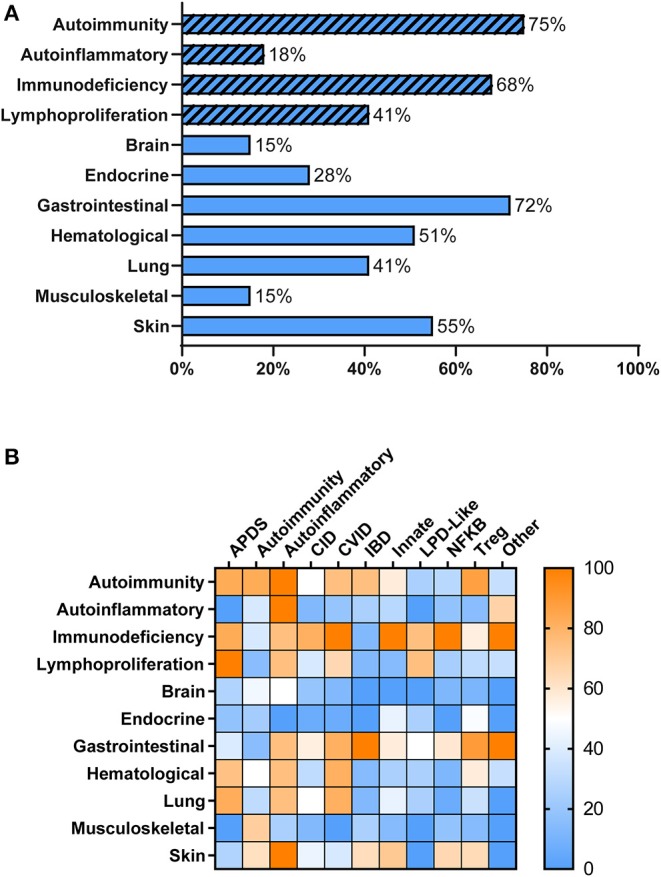
Clinical Manifestations of PIRD Patients. (A) PIRD patients have a range of clinical manifestations. Hatched bars represent the type of immune dysregulation [i.e., overactive immune features (autoimmunity, autoinflammation, lymphoproliferation) or underactive immune features (immunodeficiency)] and solid bars represent organ involvement. (B) Heat map of the clinical manifestations (rows) in the disease groups (columns). Color indicates the percentage of patients within that disease group that have the particular clinical manifestation. Right bar represents the color scaling. APDS, activated PI3K delta syndrome; CID, combined immunodeficiency; CVID, common variable immunodeficiency; IBD, inflammatory bowel disease; Innate, disorders of innate immunity; LPD, lymphoproliferative disorder; NFKB, nuclear factor kappa-light-chain-enhancer of activated B cells disorders; Tregopathies, T regulatory cell disorders.